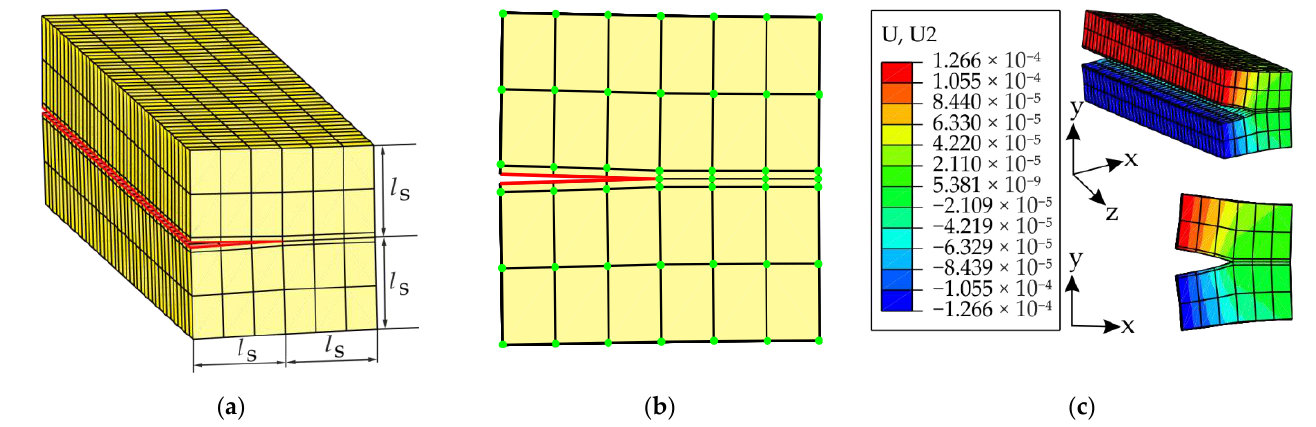
Figure 10. Geometry of the new submodel: ( a ) Submodel with smaller elements close to the crack surfaces; ( b ) Cross-section of the submodel with ‘driven nodes’, in which the nodes from the crack surfaces are not selected; ( c ). The displacement in the new submodel in the x-direction.